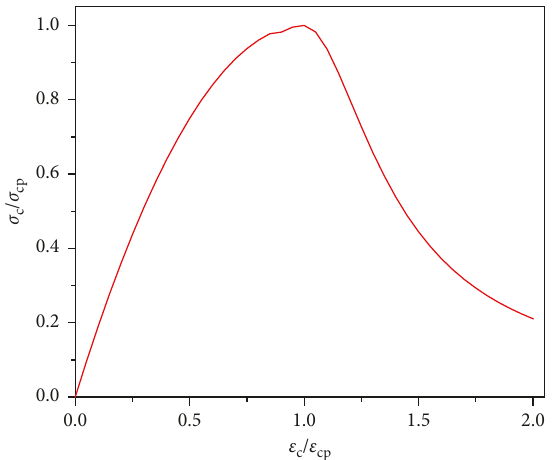
Figure 10: Stress-strain curve of